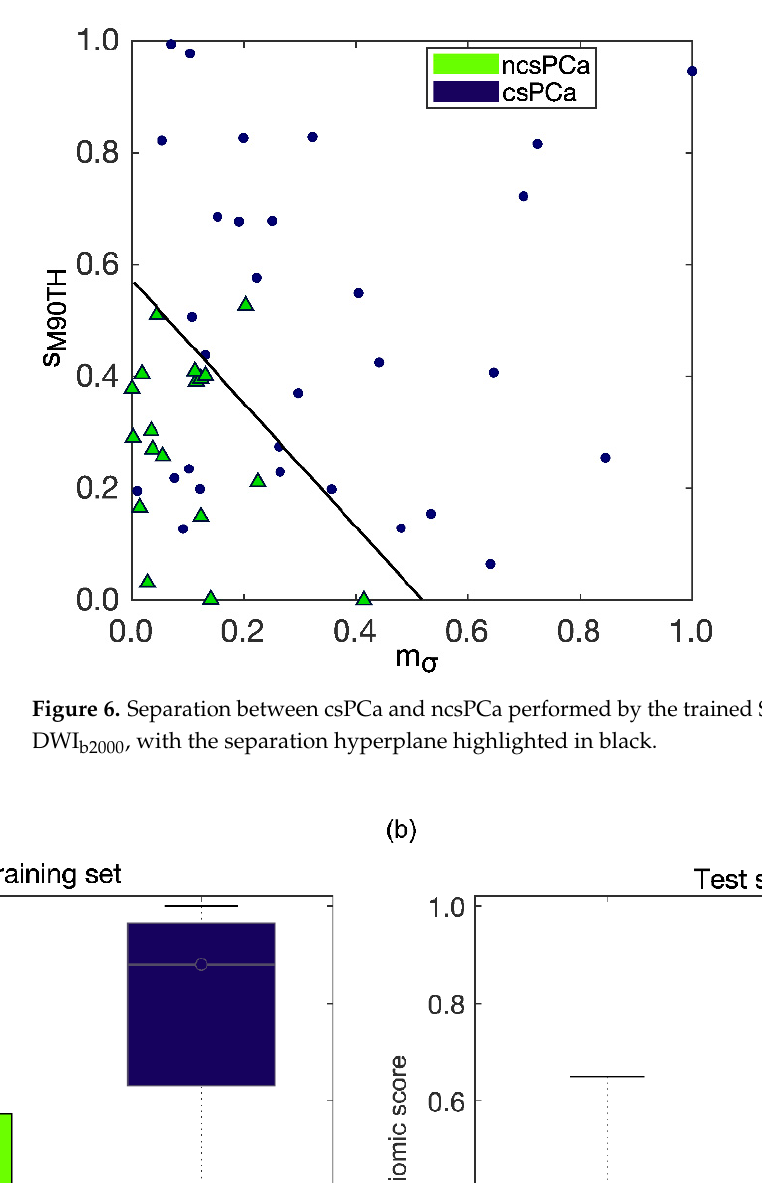
Figure 7. ( a ) The boxplot of the separation between ncsPCa (light green box) and csPCa (dark blue box) for the training set where the two groups are separated with a p -value~10 − 5 . ( b ) The boxplot of the separation between ncsPCa (light green box) and csPCa (dark blue box) for the test set, where the two groups are separated with p -value = 7 ∙ 10 − 3 .